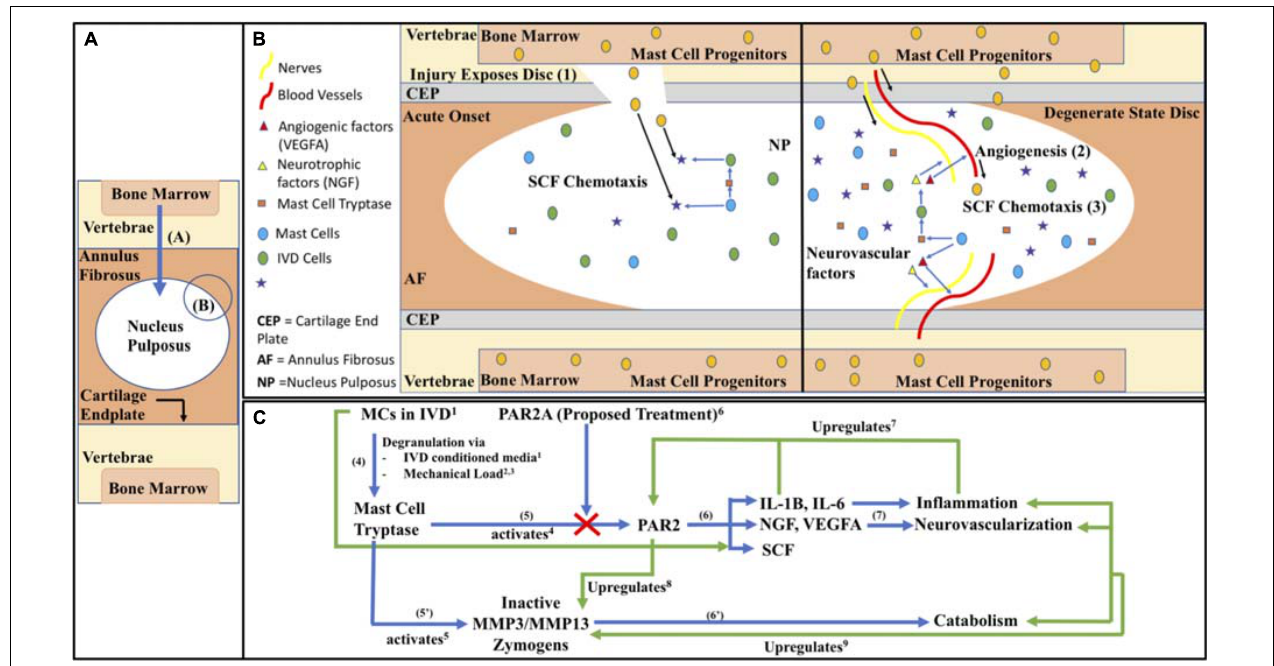
FIGURE 1 | (A) Macroscopic IVD schematic with zoomed in proposed mechanistic models of (B) MC invasion into the intradiscal environment in acute onset and chronic state as visualized through (1) Acute injury or matrix perturbation provides physical access of MC progenitors into usually immune-privileged intra-discal microenvironment acutely and (2) in the chronic state access can occur through vascularization, (3) facilitated by the MC chemoattractant SCF (KITLG). (C) Biochemical pathways of immune modulation in DBP as follows; (4) MCs in the IVD respond to mechanical load and nutrient deprivation in the harsh microenvironment by releasing tryptase (Wiet et al., 2017 1 ; Zhang et al., 2012 2 ; Fowlkes et al., 2013 3 ). Tryptase can activate (5) PAR2 directly (Molino et al., 1997 4 ) as well as (5’) matrix enzymes, matrix metalloproteinases 3 and 13 (MMPs) (Magarinos et al., 2013 5 ). (6) PAR2 activation by tryptase, abated by PAR2A (Chen et al., 2011 6 ) in the present study, leads to downstream factors related to catabolism, (6’) such as MMPs (Lee et al., 2010 8 ), which can degrade the proteoglycan aggrecan (Magarinos et al., 2013 5 ) creating an increasingly permissive environment for inflammation and stimulating increased activation of endogenous pro-MMP (Vo et al., 2013 9 ). (7) PAR2’s activation also leads to downstream factors related to inflammation, neo-vascularization/neo-innervation, and MC chemotaxis contributing to a synergistic positive feedback loop, whereas PAR2’s activation upregulates its own expression through IL-1 β , ad general inflammation, perpetuating a chronic degenerate state (Ritchie et al., 2007 7 ). Black Arrows represent labeling or directionality, Blue arrows represent forward mechanism steps, Green arrows represent feedback interactions. (C) Blunt arrow ends represent effects coming from, pointed ends represent effects going to, and bidirectional pointed ends represent co-regulatory